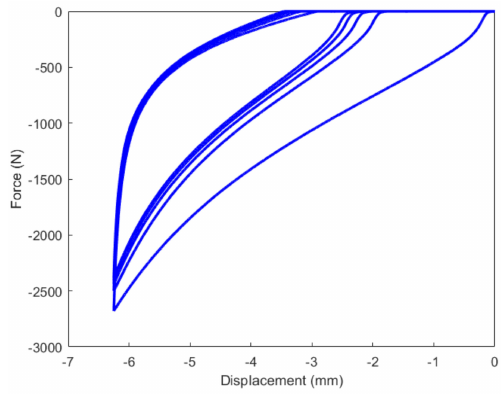
Figure 9. Result of the cyclic compression